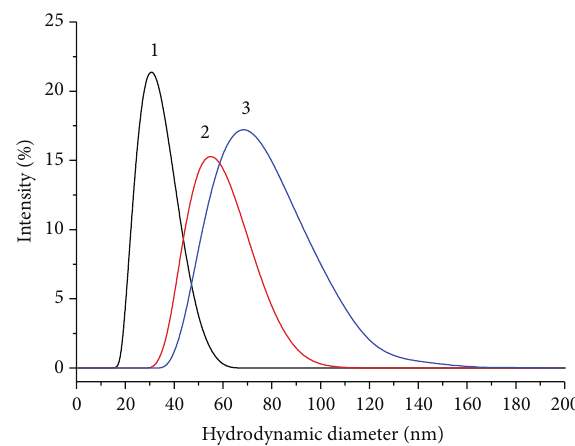
Figure 3: TC-competitive EIA: dependence of the recorded absorb- ency on the analyte concentration.